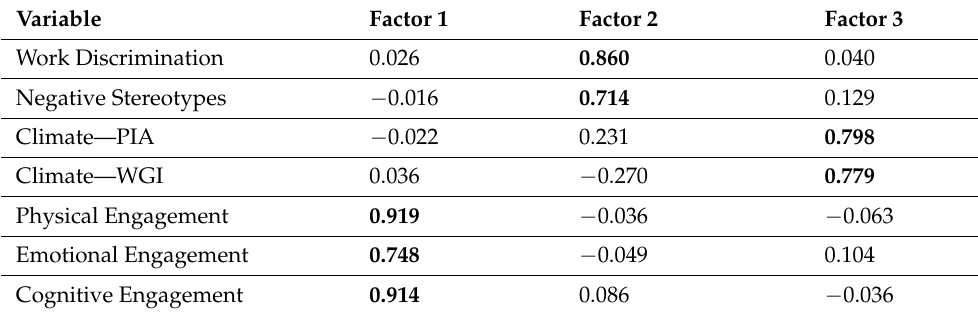
Table 2. Rotated pattern matrix loading of the predictor variables.